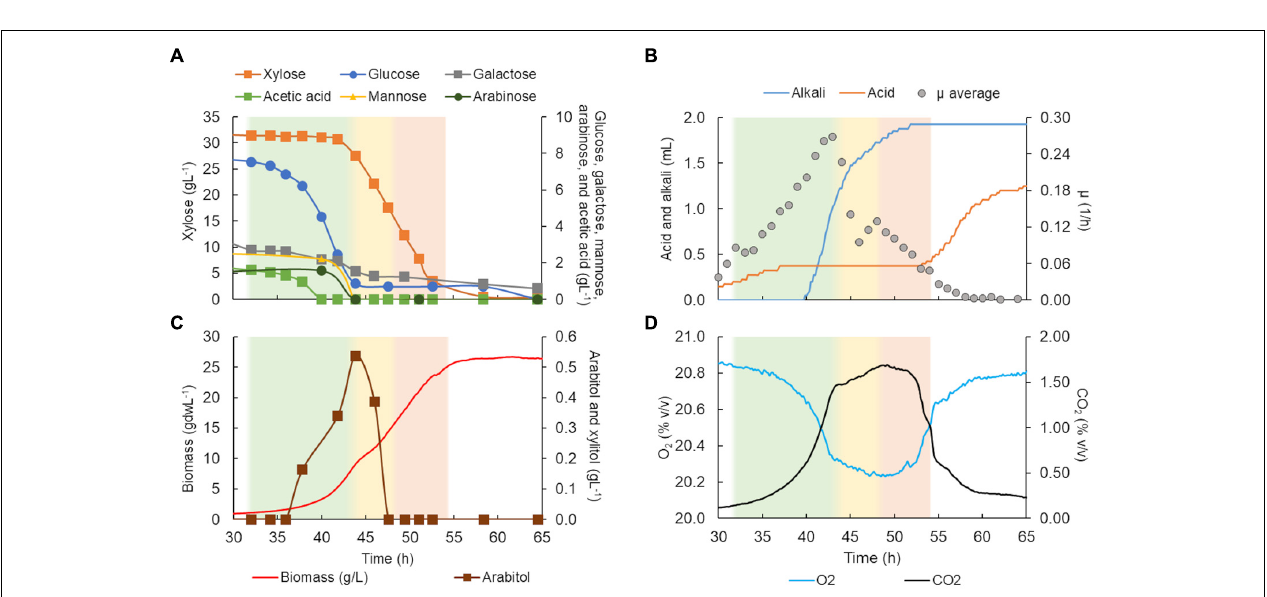
FIGURE 4 | Scheffersomyces stipitis CBS 5773 characterization in a bioreactor in C5-Birch hydrolysate diluted to 50 gL − 1 of total sugars. (A) Xylose, glucose, galactose, mannose, arabinose, and acetic acid consumption profiles (gL − 1 ); (B) added alkali and acid profiles to maintain the constant pH and average specific growth rate ( µ , h − 1 ); (C) xylitol and arabitol production and consumption profiles (gL − 1 ) and growth profile in biomass (gdwL − 1 ); and (D) CO 2 production and O 2 consumed gases profiles. The lag phase is depicted in white (the graph stated at 30 h); the first and second growth phases are shown in green and yellow, respectively. Supplementary Table 4 contains all data and errors expressed in standard deviation.